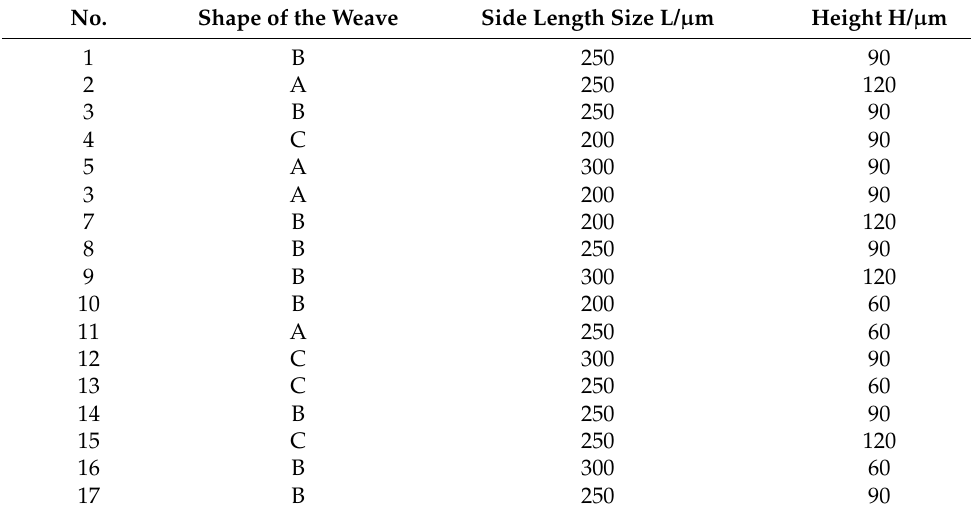
Table 10. Experimental design scheme for surface micro-nano